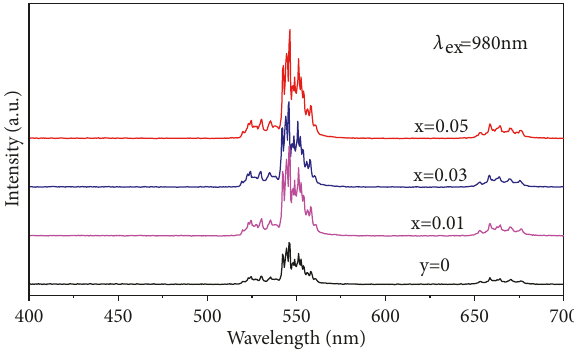
Figure 2: UCPL spectra of Gd(Al 1